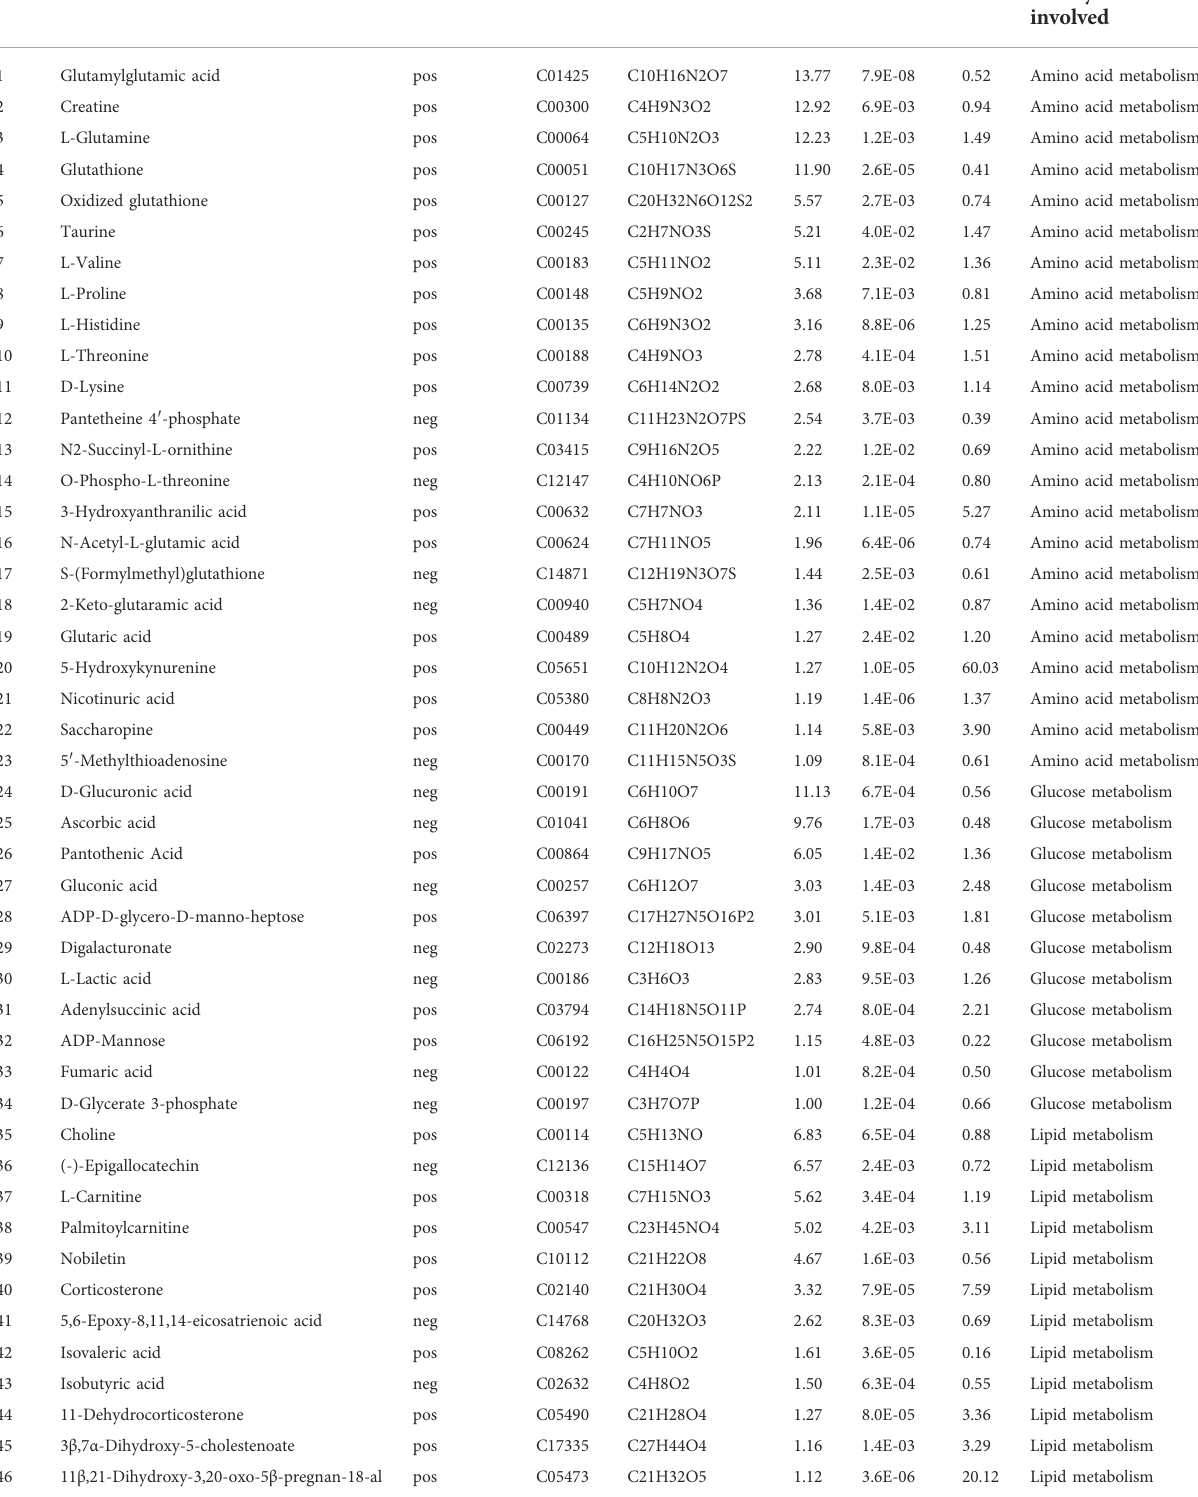
TABLE 1 Differentially expressed metabolites in the hippocampus between sepsis-associated encephalopathy and control group.